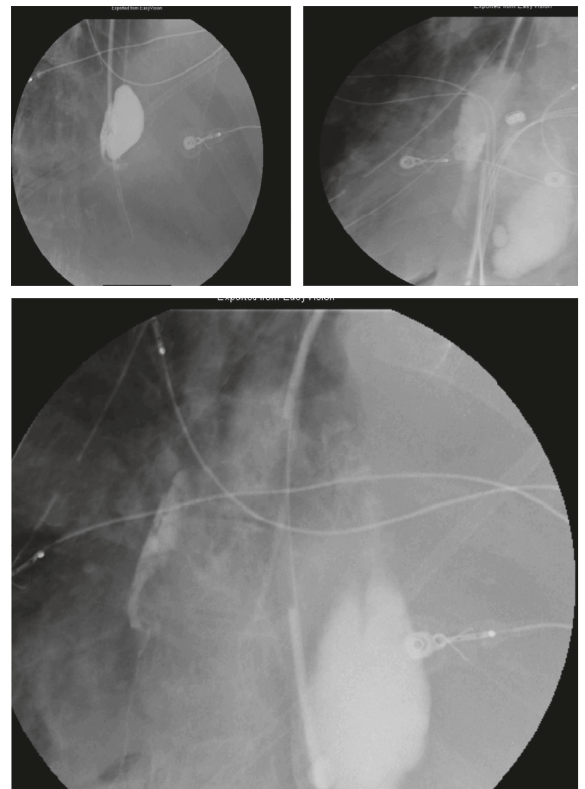
Figure 3: A barium swallow showing contrast extravasation into the right pleural cavity confirming esophageal perforation.